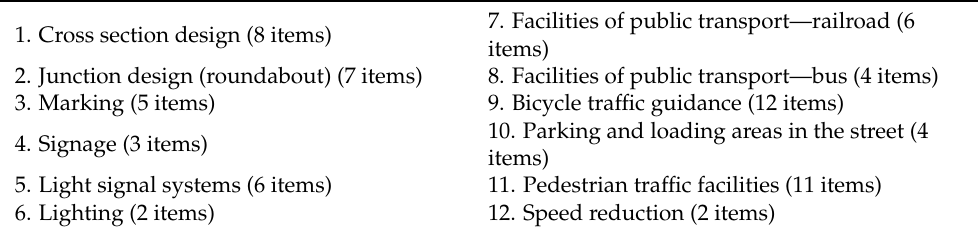
Table 1. 12 scales of the deficit inventory (BASt) in the abbreviated version with 70